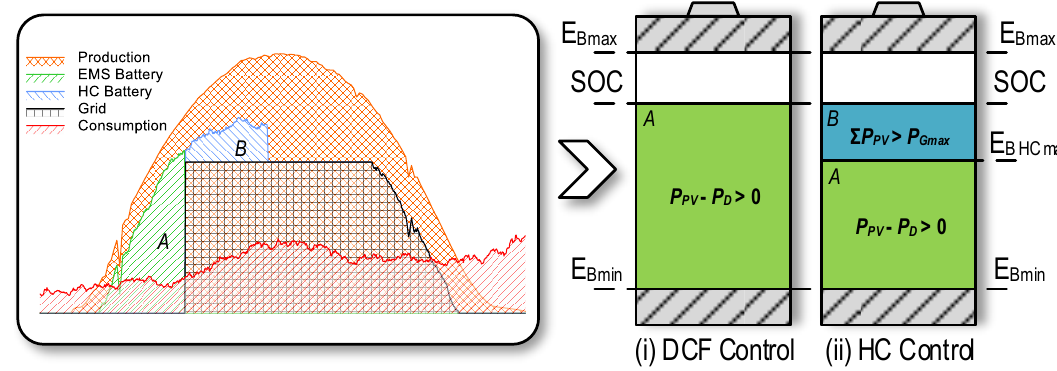
Figure 4. Control strategies for the SCEMS when soft curtailment. Daily profile and battery